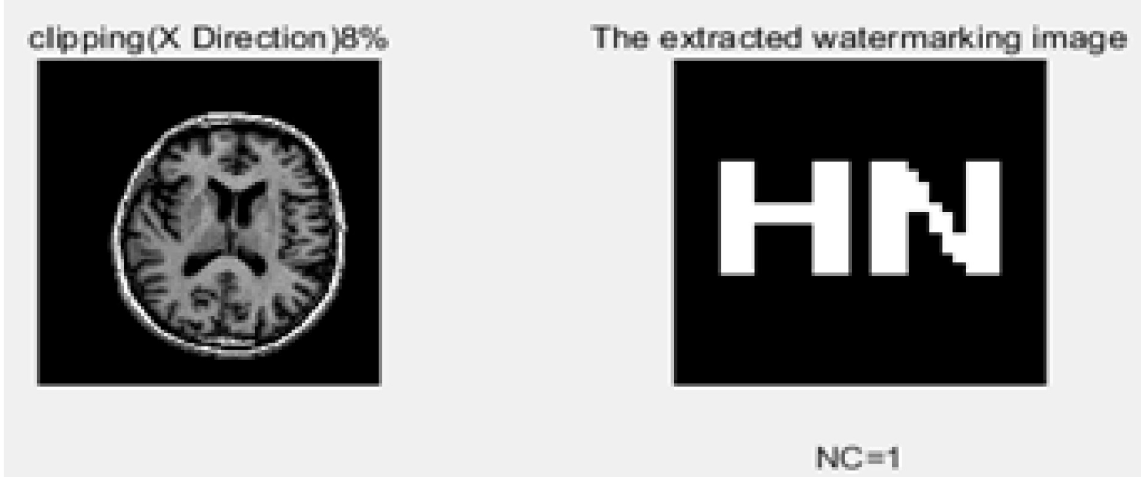
Fig 13. Clipping attack on the x-axis after 8%.